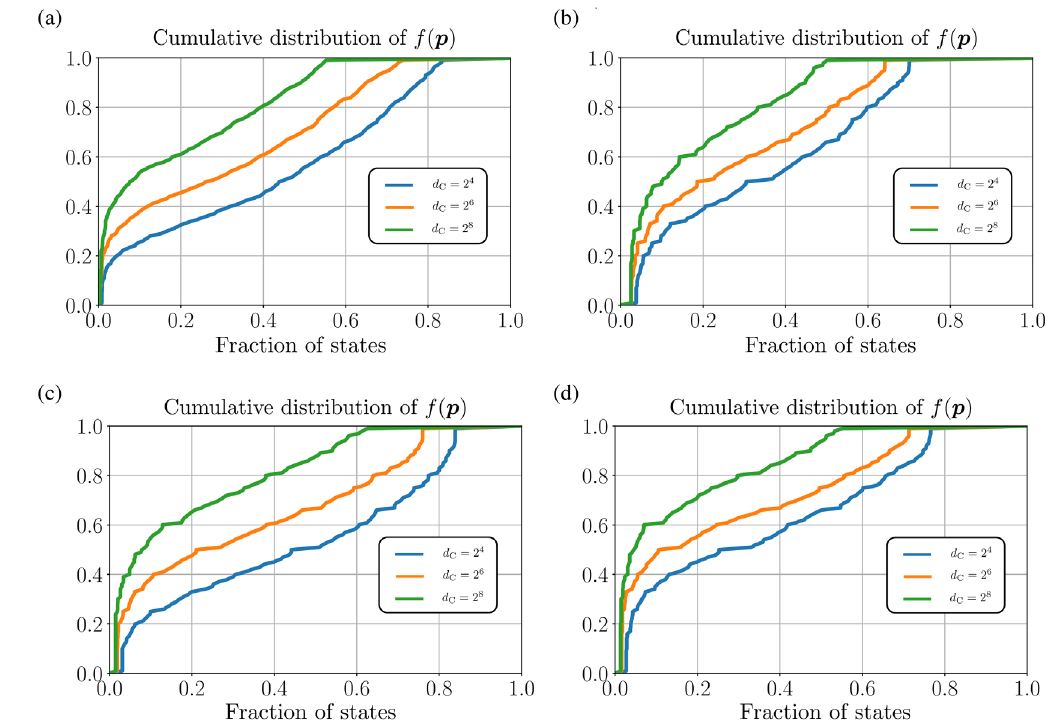
(2019).FIG. 7. Cumulative distribution of f ð p Þ for different choices of